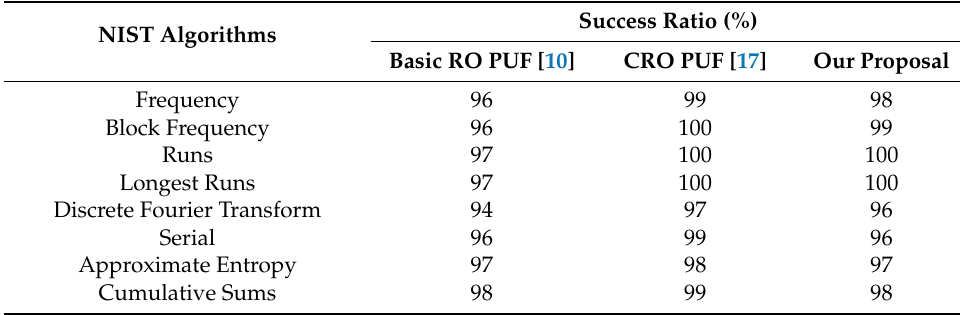
Table 1. Success ratio of three types of RO PUFs in the NIST randomness test. Success Ratio (%) NIST Algorithms Basic RO PUF [10] CRO PUF [17] Our